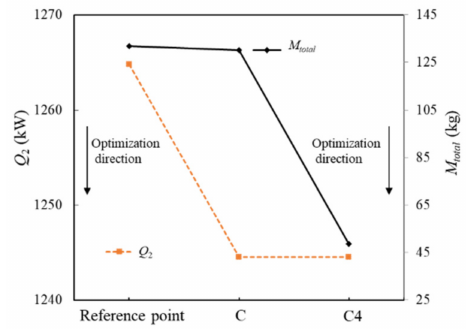
Figure 15. Comparison of optimization